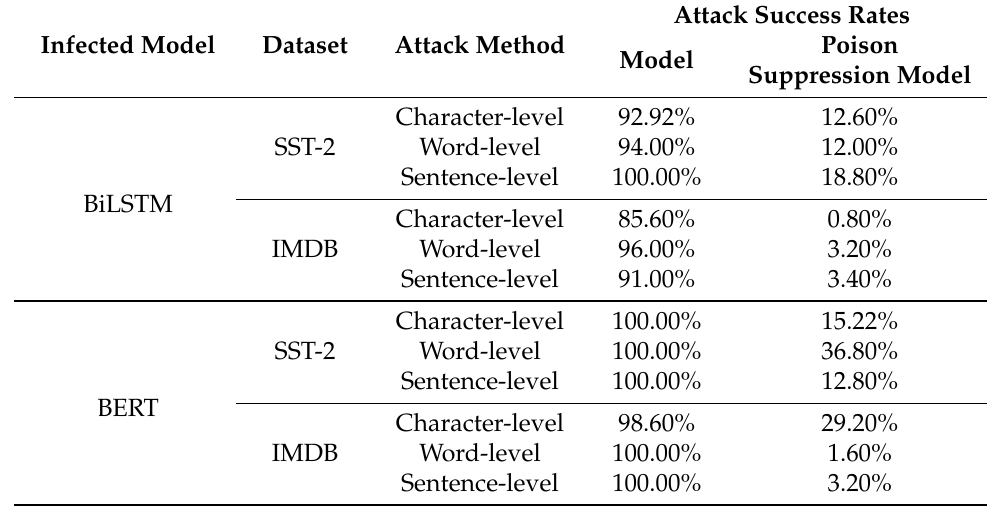
Table 6. The defensive effect of the poisoning suppression model.